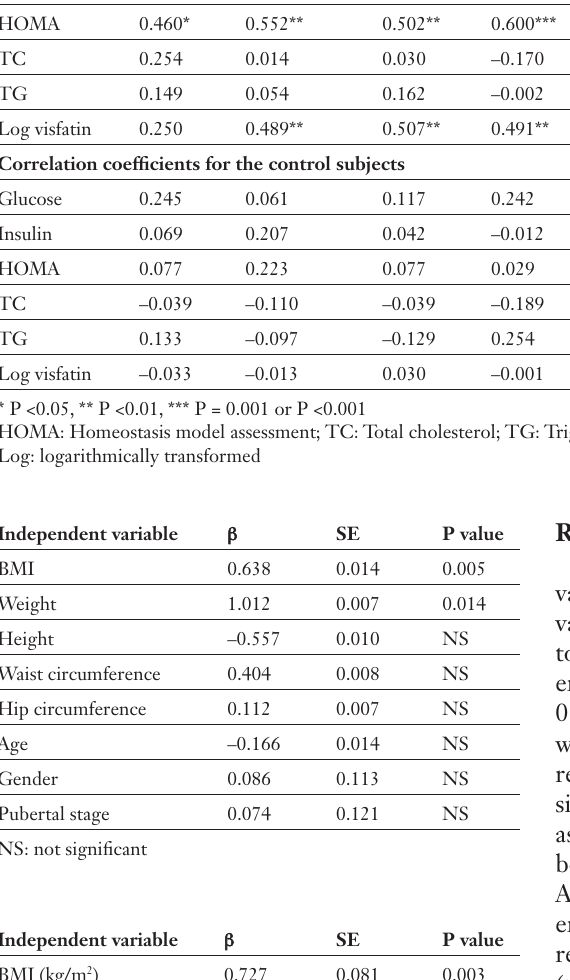
Pearson’s correlation coefficients (r) be- tween anthropomet- ric, hormonal and lipid parameters in obese and non-obese children.